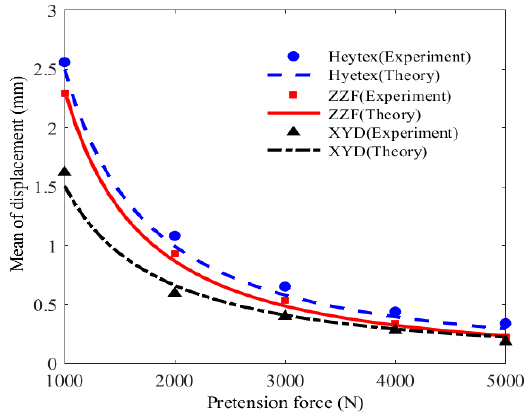
Figure 20. Mean value of displacement versus membrane material.